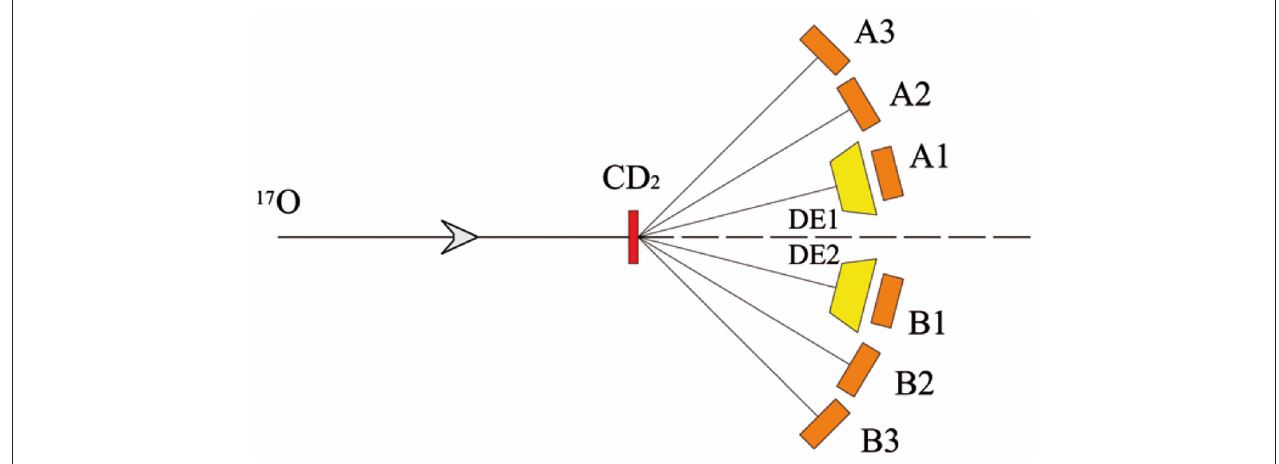
FIGURE 9 | Sketch of the experimental setup. The 17 O beam was impinging on a CD 2 target. The emitted particles were detected by four PSDs (A2, A3, B2, and B3) and by two 1 E-E telescopes (DE1-A1 and DE2-B1).